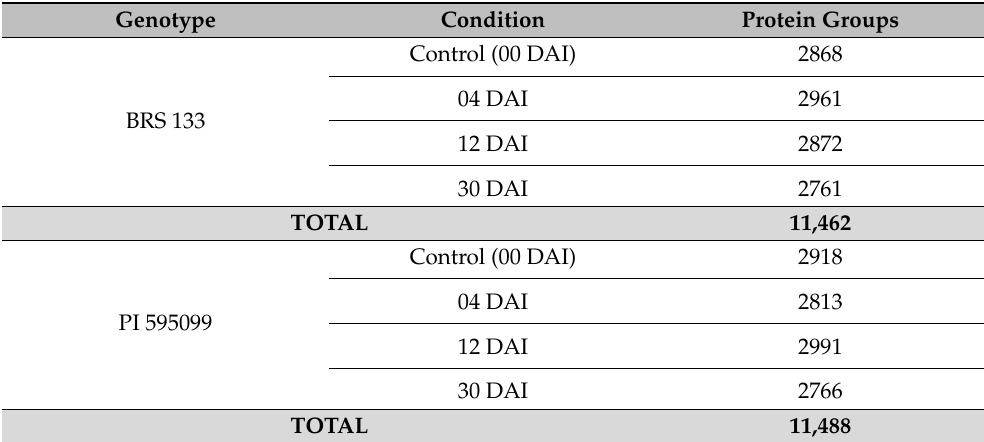
Table 2. Summary of proteome data from BRS 133 and PI 595099 soybean genotypes. Genotype Condition Protein